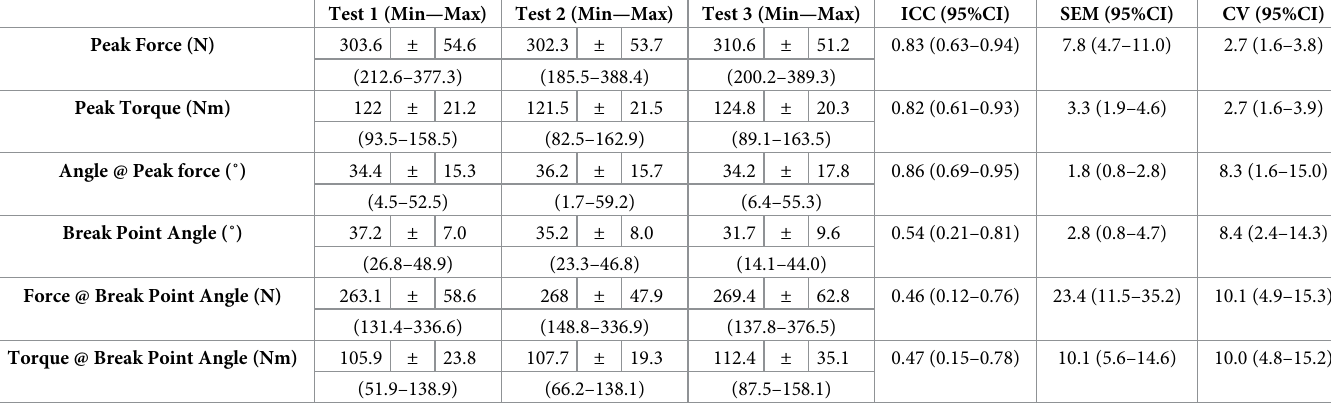
Table 1. Nordic hamstring peak force and peak torque, angle at peak force, break point angle, and force and torque at break point angle (mean ± SD, range of 16 participants) over three trials (Test 1 –Test 3) for intraclass correlation coefficient (ICC), standard error of measurement (SEM) and coefficient of variation (CV) with 95% confidence interval (95%CI).